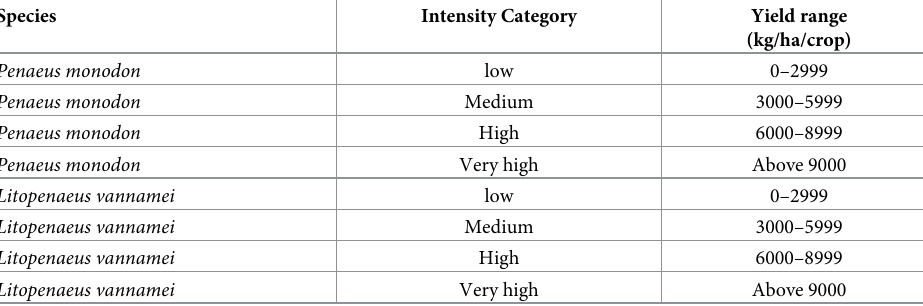
Table 2. Clusters identified for economic analysis.